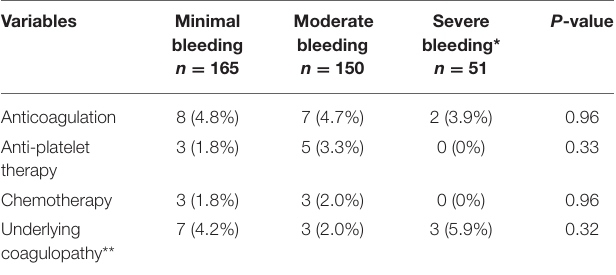
TABLE 3 | Underlying conditions potentially associated with risk of bleeding, evaluated on the day of bleeding. Variables